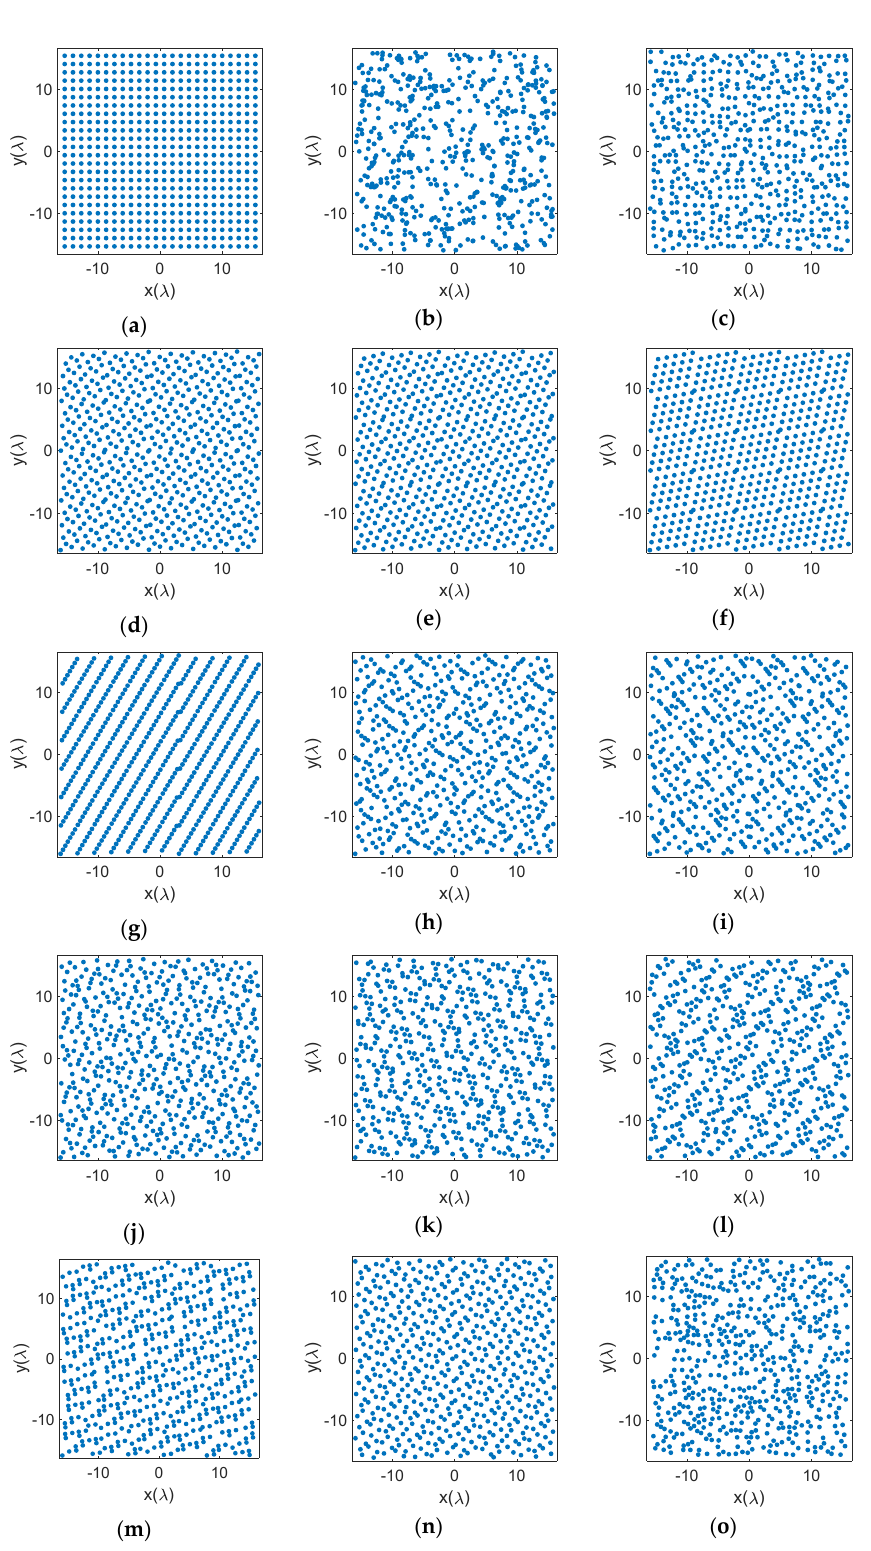
Figure 3. Position of elements on the aperture with different distributions: ( a ) uniform, ( b ) random, ( c ) random with jitter, ( d ) Hammersley (base 2), ( e ) Hammersley (base 3), ( f ) Hammersley (base 5), ( g ) Hammersley (base 7), ( h ) Halton (bases 2, 3), ( i ) Halton (bases 2, 5), ( j ) Halton (bases 2, 7), ( k ) Halton (bases 3, 5), ( l ) Halton (bases 3, 7), ( m ) Halton (bases 5, 7), ( n ) Sobol, ( o ) Poisson disk.